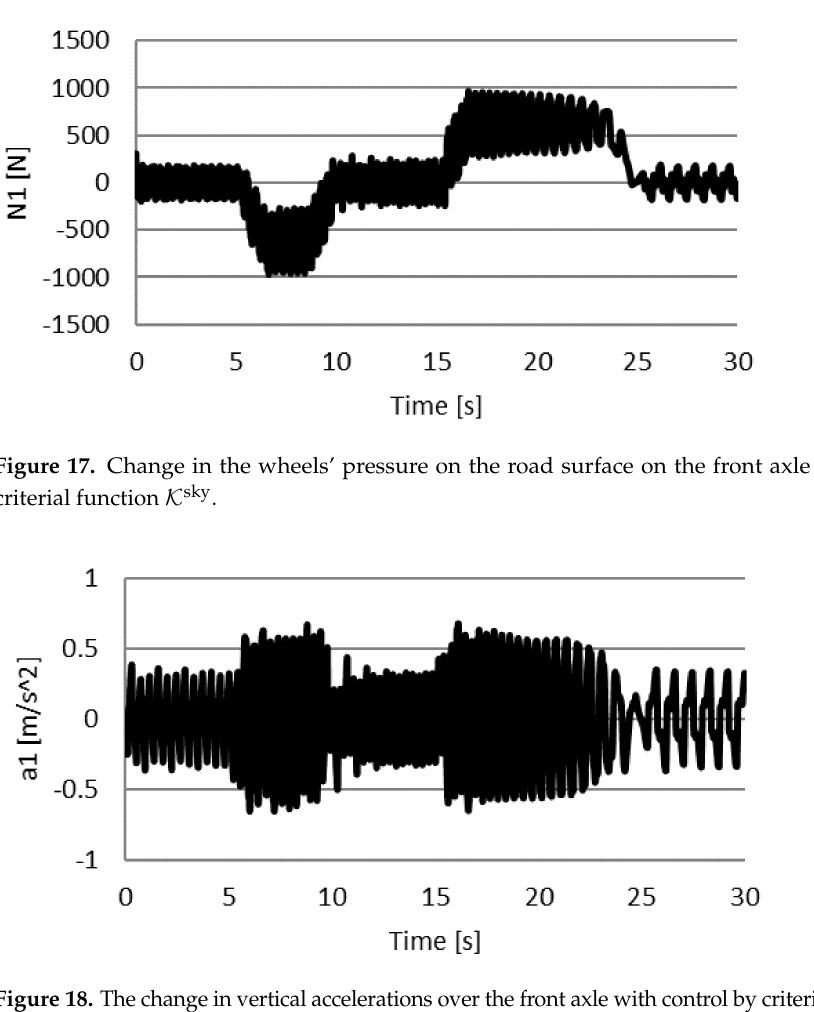
Figure 18. The change in vertical accelerations over the front axle with control by criterial function K sky .